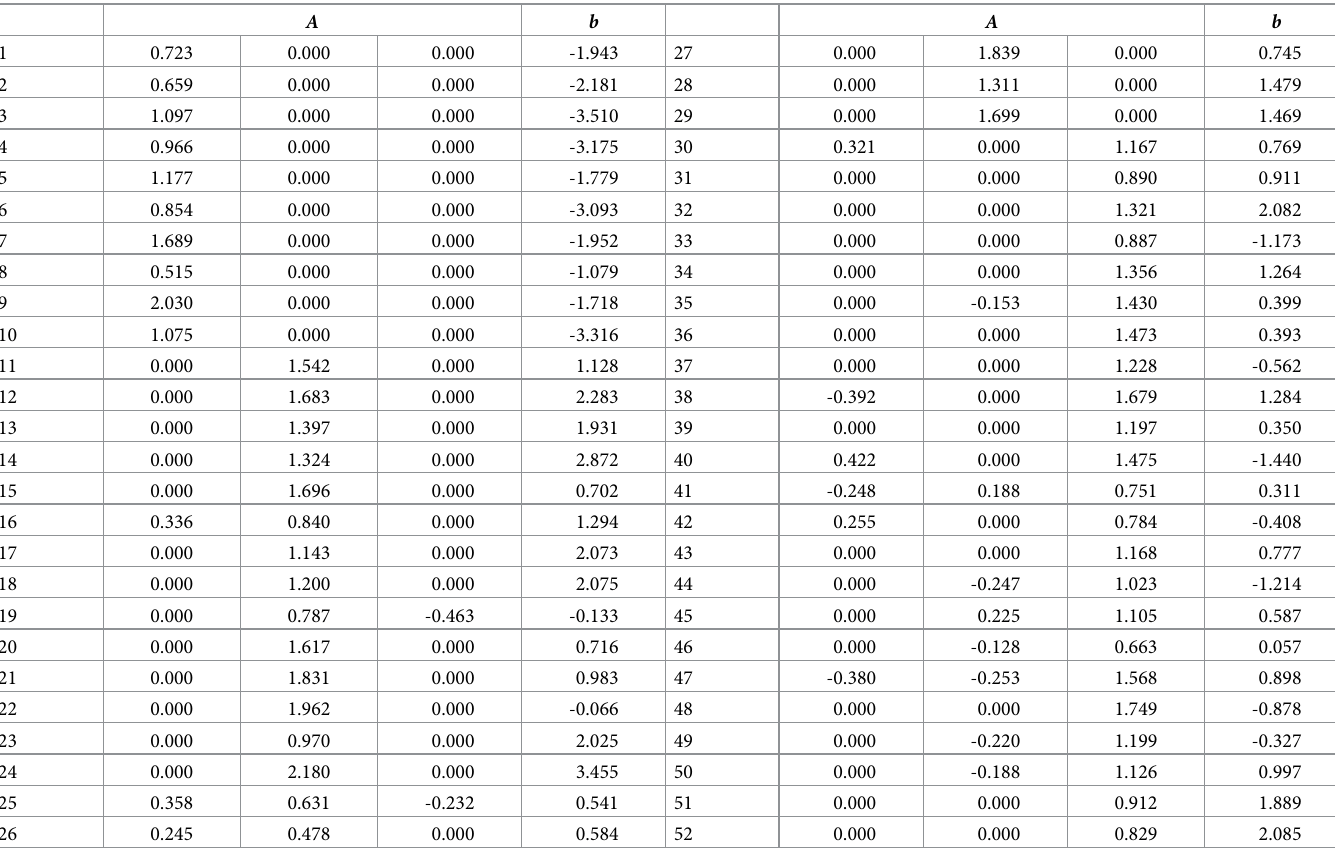
Table 4. The parameter estimates by the IEML1 algorithm for the real